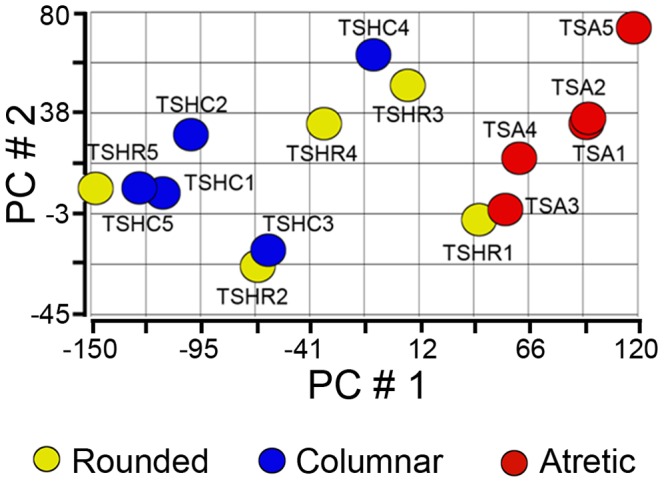
Unsupervised PCA of arrays from theca interna of small healthy and atretic follicles.The healthy follicles were separated into rounded (n = 5) and columnar (The graph is a scatter plot of the values for the first (X-axis) and second (Y-axis) principal components based on the Pearson correlation matrix of the total normalized array intensity data. The numbering of each sample enables the samples in this figure to be identified in Fig. S1. Abbreviations are: thecal sample healthy rounded (TSHR), thecal sample healthy columnar (TSHC) and thecal sample atretic (TSA).